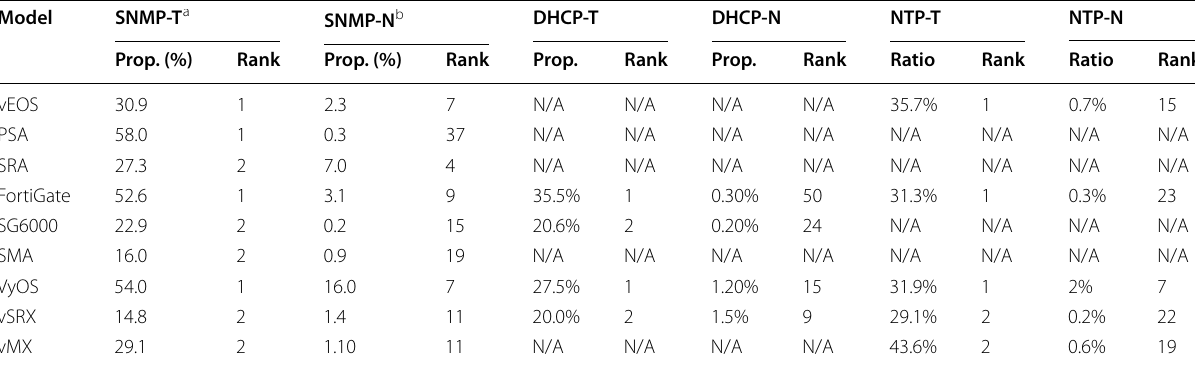
a T suffix means -Trigger, shows the ratio and rank of switching times of target PGD during the 1000 times process switching with trigger b N suffix means -Normal, shows the ratio and rank of switching times of target PGD during the 1000 times process switching in normal